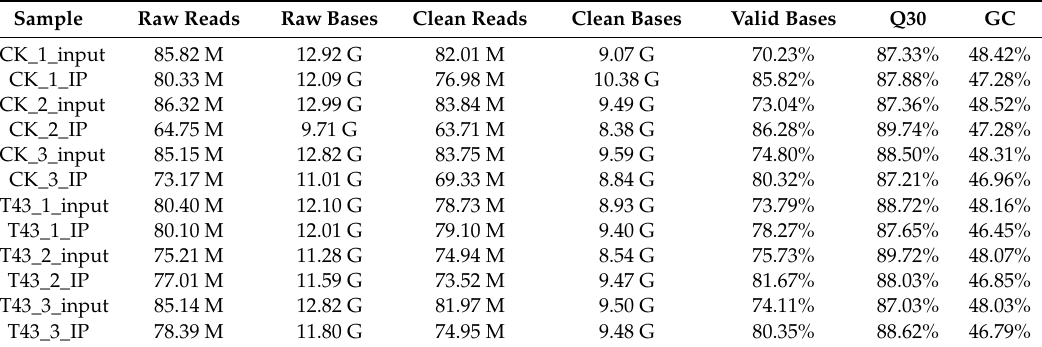
Table 1. Statistics and quality control of raw data generated by sequencing.